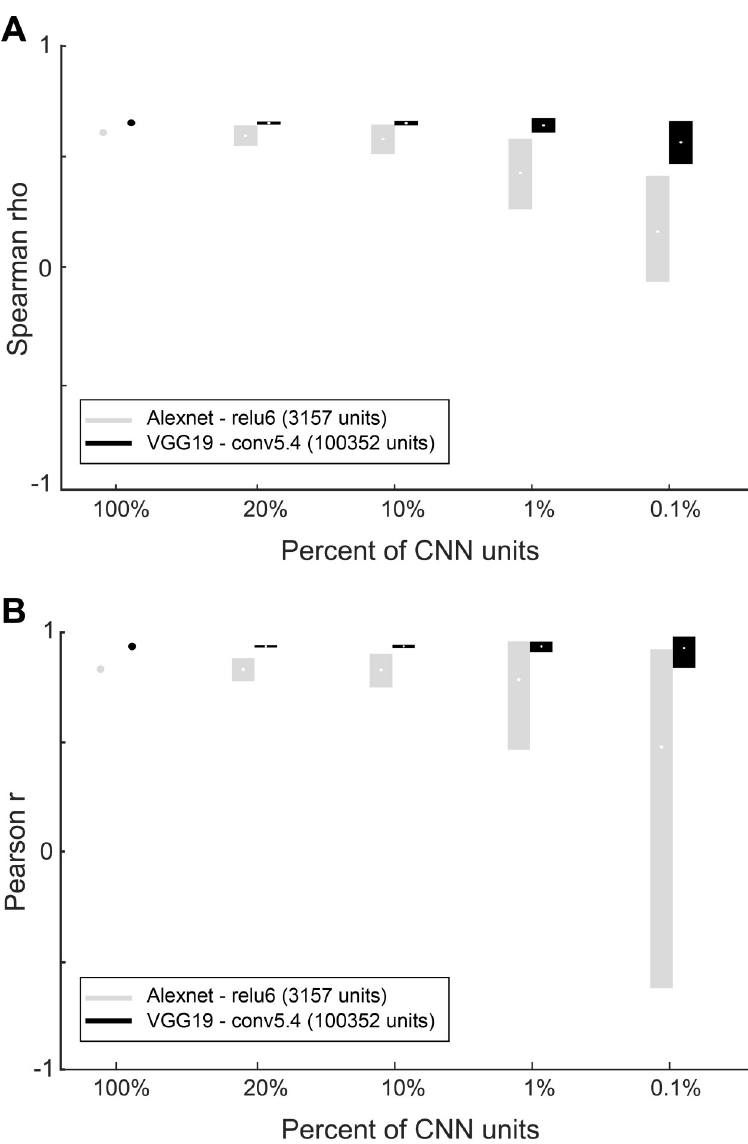
Fig 6. Similarities between IT and CNN peak layer shape dissimilarities as a function of percent of units. (A) Spearman rank correlation coefficients between IT and peak CNN layer similarities are shown for each of two CNN models as a function of sample size, expressed as percentage of the total number of units that were activated differentially by the 64 shapes. (B) Pearson correlation coefficients between the mean neural distances and the mean distances of the peak CNN layer (n = 6 mean distances; Fig 10) as a function of percentage of the total number of units. The total number of units (100%) for each CNN layer is listed in the legend. Note that 0.1% corresponds to only 3 Alexnet units, explaining the large range of correlations for that sample size. The dissimilarities were Euclidean distances. Error bars depict 95% confidence intervals, determined by 10,000 random samples from the population of differentially activated CNN units of that